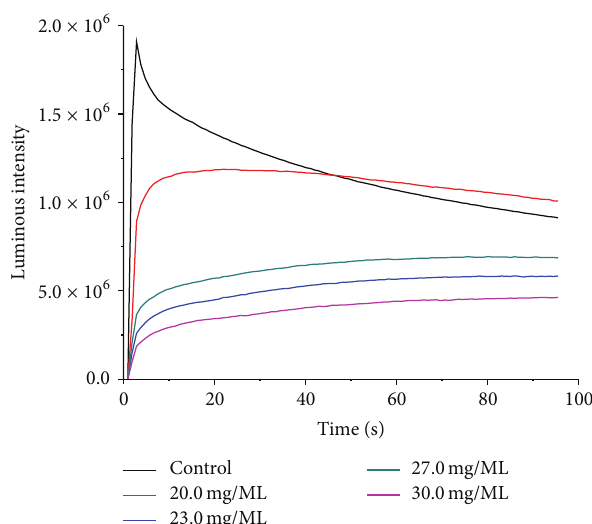
Figure 2: Inhibition of different concentrations of ophiurasaponin to superoxide anion: 1.1mg/mL, 1.5mg/mL, 2.2 mg/mL, 4.4 mg/mL, and 22 mg/mL.